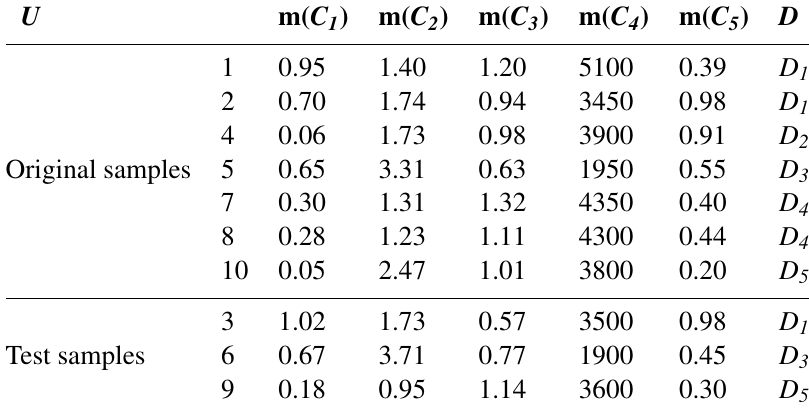
Table 2 Table of fault information.